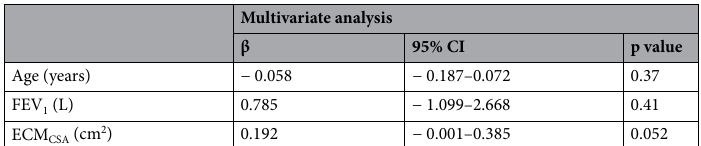
˙ VO 2 at peak exercise and age, FEV 1 , and ECM CSA